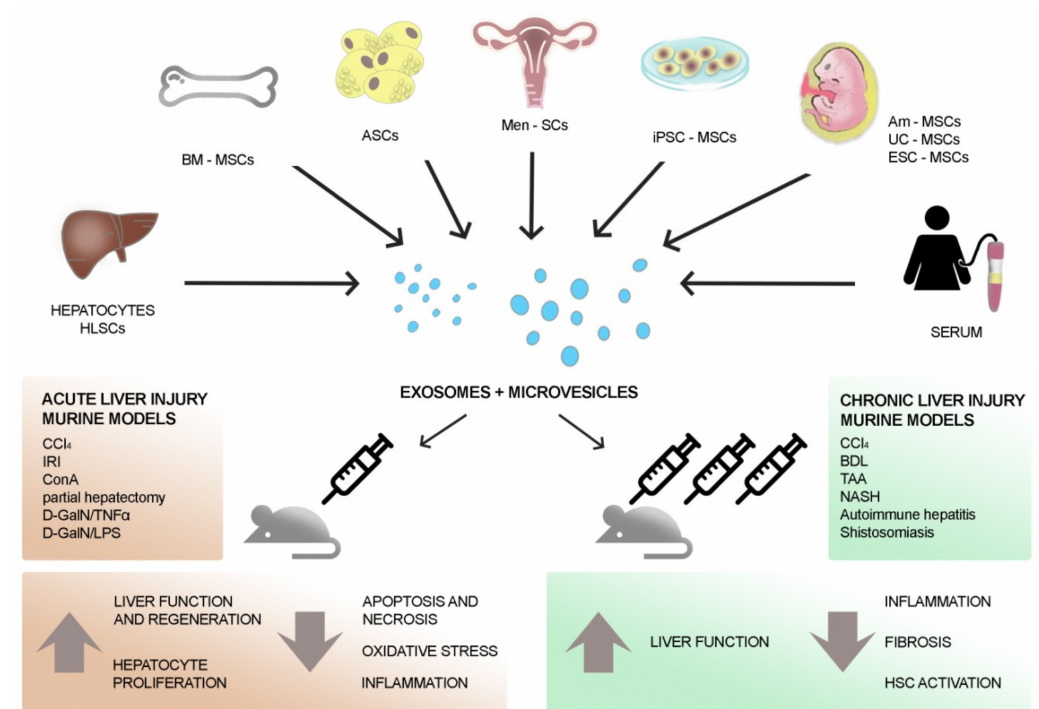
Figure 2. Therapeutic effects of EVs on hepatic injury. EVs secreted by mesenchymal stromal cells (MSCs) of different origin (such as liver, bone marrow, adipose tissue, menstrual blood, amnion, and umbilical cord) show therapeutic benefits on both acute and chronic liver injury models. Moreover, MSC-EVs derived from other stem cells (e.g., embryonic stem cell (ESC), induced pluripotent stem cells (iPSCs)), di ff erentiated cells (e.g., hepatocytes), and serum contribute to the recovery of liver cells after damage. Acute liver injury models often foresee a single injection of EVs that prompts liver regeneration by supporting the proliferation of surviving liver cells and the reduction of oxidative stress and inflammation. Chronic liver injury models require several injections of EVs that restore liver function mainly through the reduction of hepatic fibrosis. CCl, carbon tetrachloride; IRI, ischemia-reperfusion injury; LPS, lipopolysaccharide; TNF, tumor necrosis factor; D-GalN, D-galactosamine; HLSC, human liver stem cell; hCB, human cord blood; hASC, human adipose stem cell; NASH, non-alcoholic steato-hepatitis; TAA, thioacetamide; BDL, bile duct